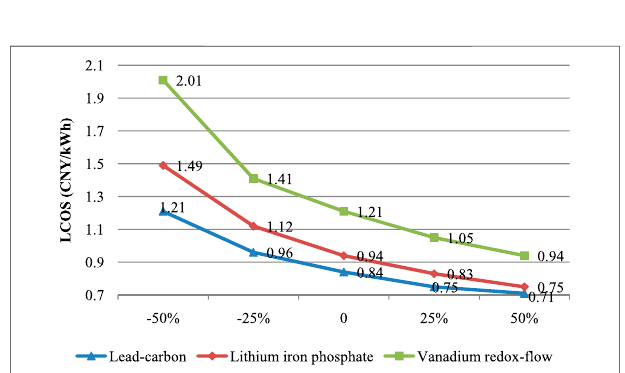
FIGURE 12 | Sensitivity analysis of the storage duration to the LCOS of EES.